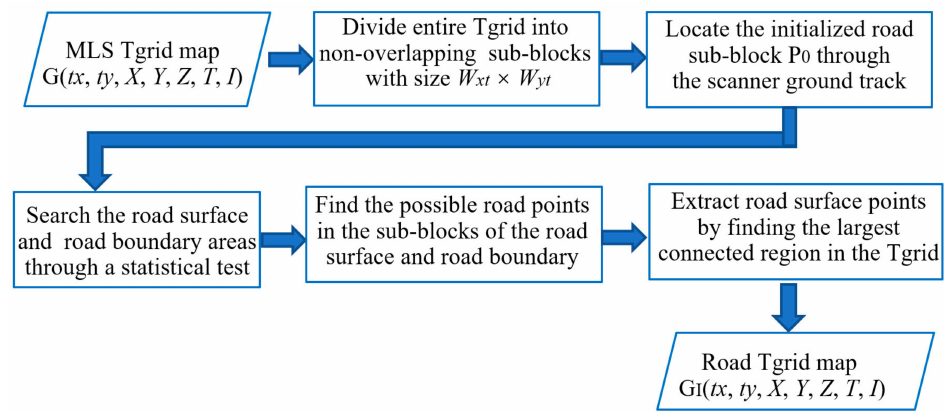
Figure 6. The flow chart of the method of detection of road surface